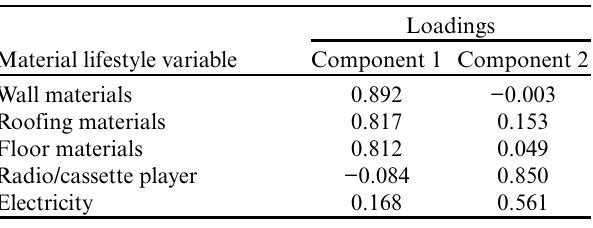
Table 3. Rotated factor loadings from principal component analysis of the material lifestyle